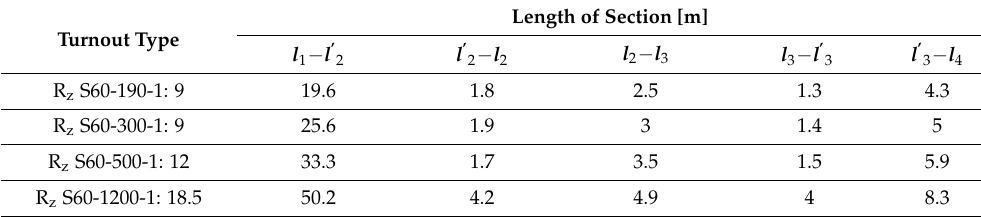
Table 6. Lengths of individual sections in the various S-60 ordinary turnouts. Turnout